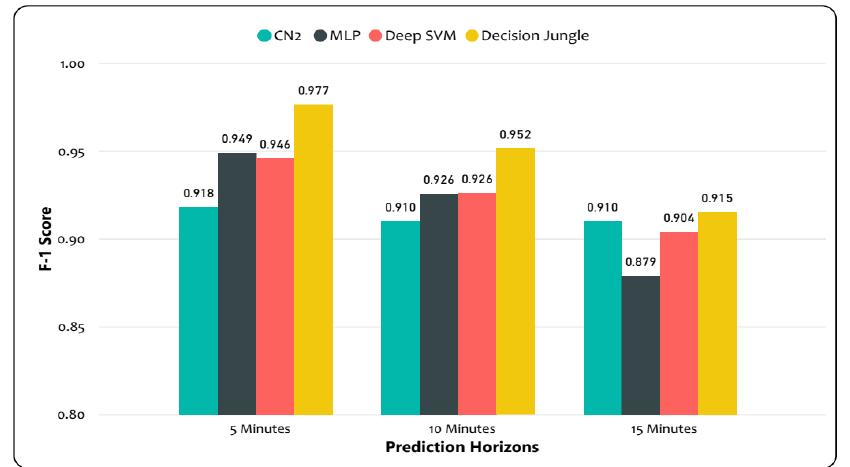
Figure 12. Model comparison. Weighted average F-1 score for decision jungles; weighted average F-1 score for LD-SVM; weighted average F-1 score for MLP; weighted average F-1 score for CN2 rule induction.